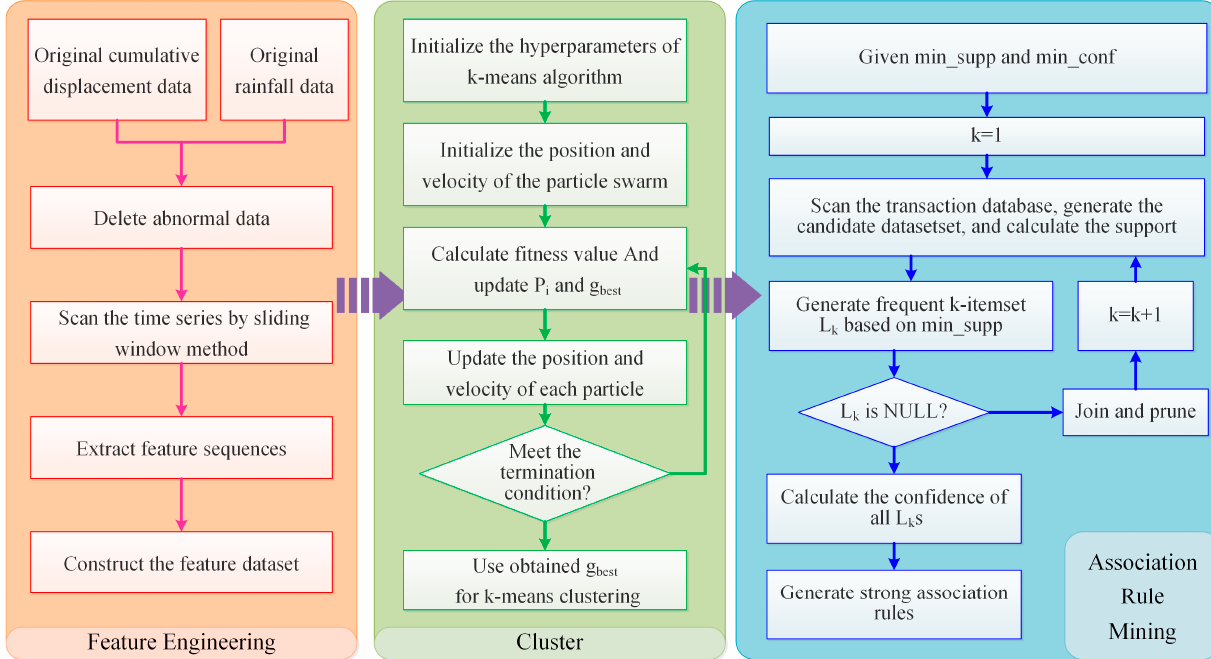
Figure 1. Flowchart of association rule mining for the Lishanyuan landslide.